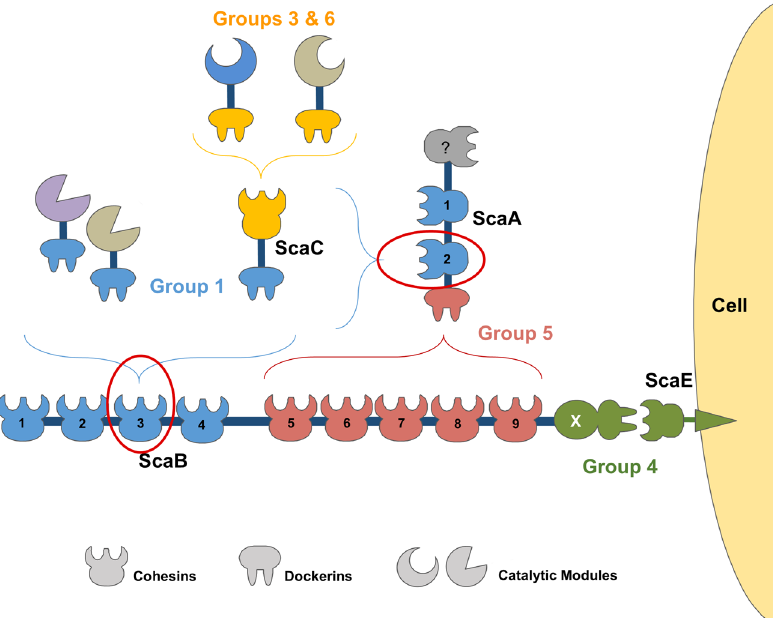
Figure 1. Group-specific interactions that contribute to the major cellulosome assembly in R . flavefaciens strain FD-1. The scheme is color-coded to highlight the four subgroups of cohesin-dockerin specificities: Dockerins and cognate cohesin counterparts of the different groups are marked in blue (Group 1 dockerins), yellow (Groups 3 and 6), green (Groups 2 and 4) and red (Group 5), respectively. Group 2 dockerins are truncated derivatives of group 4 and are not represented in the figure for simplification. The red ovals mark the complexes of the Group 1 interactions, whose structures are reported